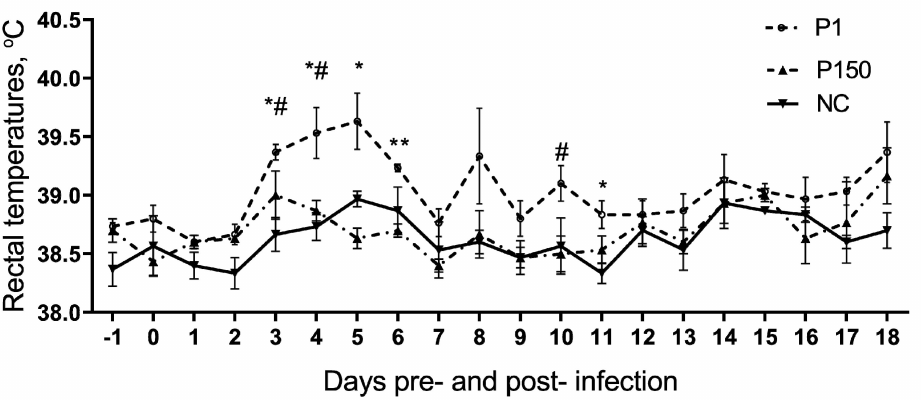
Figure 1. Rectal temperature curves of experimental calves pre- and post- infection by virulent and attenuated Mycoplasma bovis strains compared with mock-infected group (NC). The di ff erence in the rectal temperature is statistically di ff erent between P1 and P150 (P150) groups (* p < 0.05 and ** p < 0.01) and between P1 and NC (# p < 0.05).